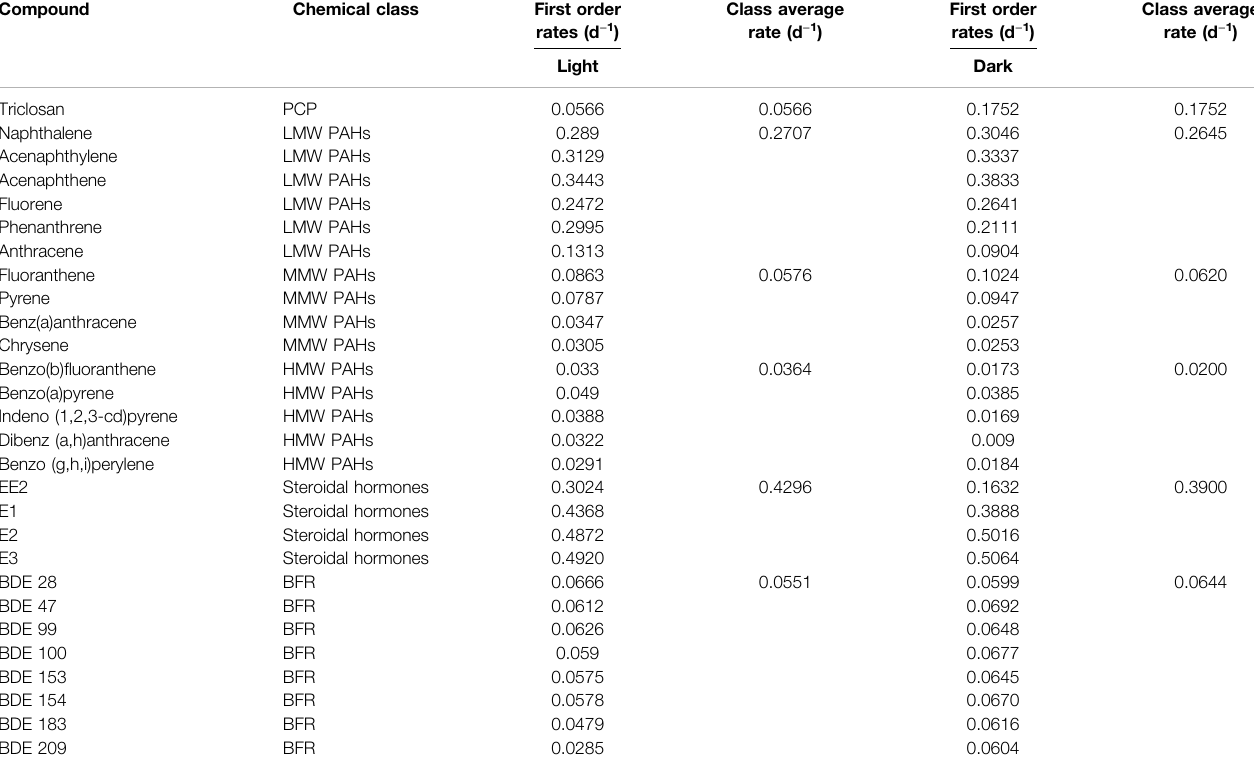
TABLE 2 | Degradation rates of different classes of chemicals under aerobic conditions with facultative pond inocula.